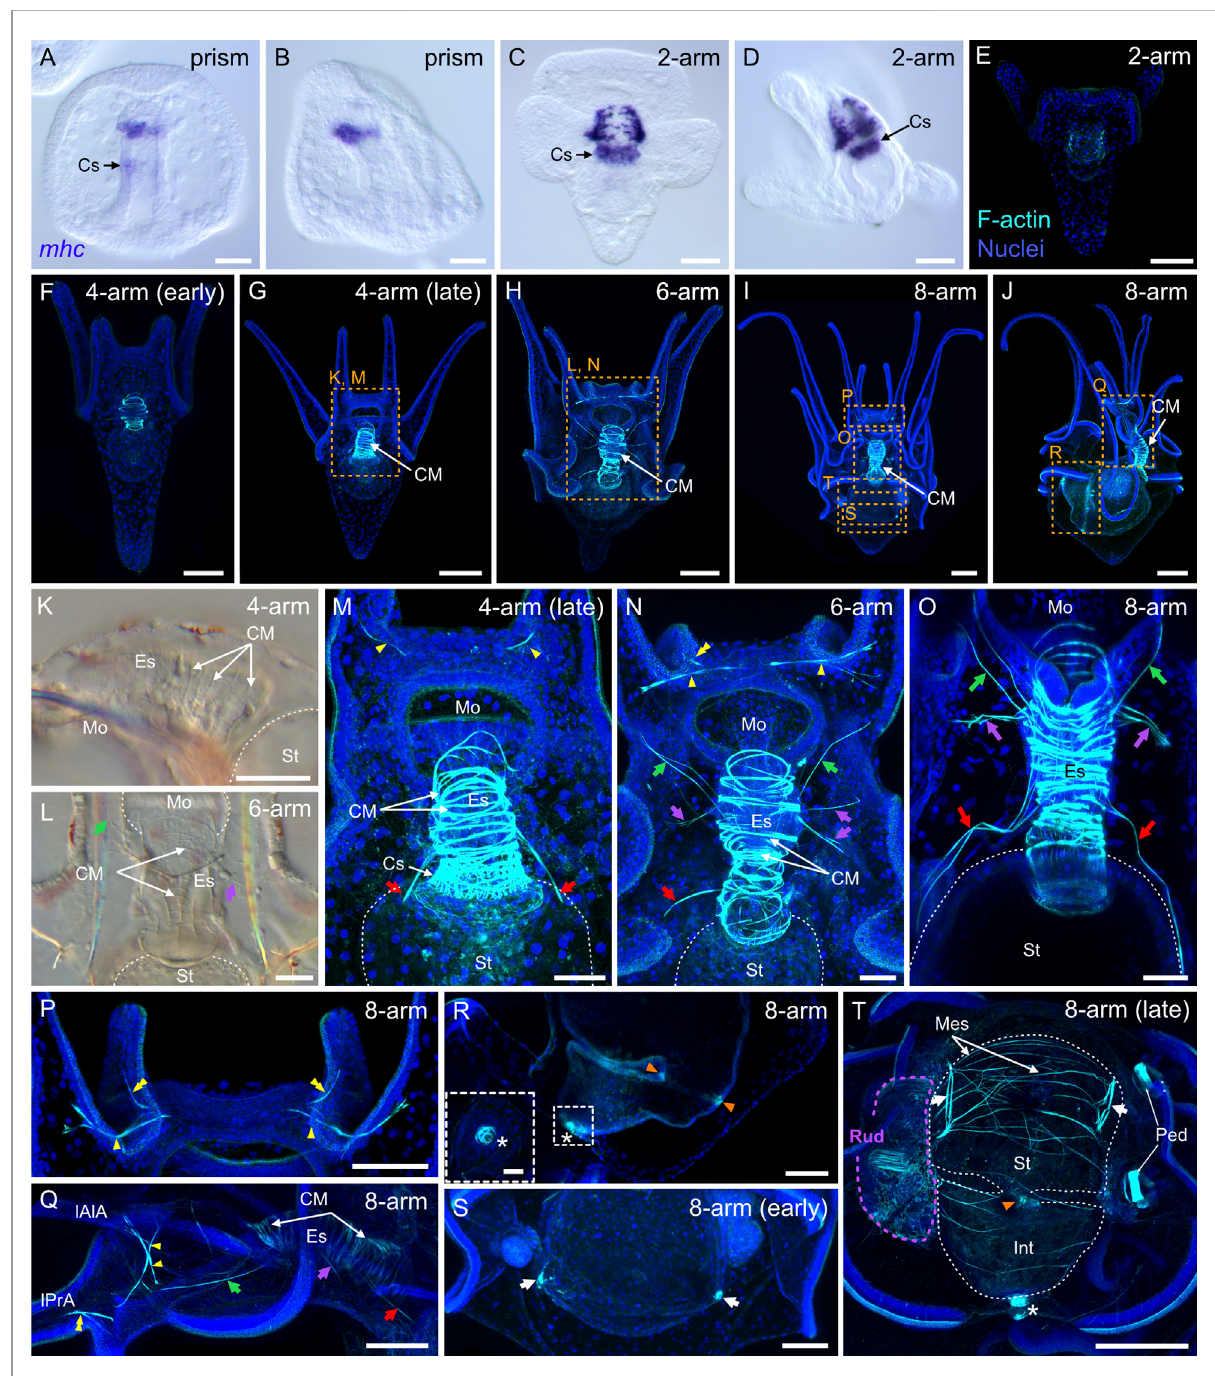
FIGURE 10 Myogenesis in Paracentrotus lividus during the embryonic and larval periods. Developmental stages are as follows: (A,B) prism stage (prism); (C – E) 2-arm pluteus stage (2-arm); (F,G,K,M) 4-arm pluteus stage (4-arm); (H,L,N) 6-arm pluteus stage (6-arm); (I,J,O – T) 8-arm pluteus stage (8- arm).Theuseof(early)or(late)associatedwiththestagenamessimplyhighlightsheremorespeci fi cperiodsduringthe4-or8-armpluteusstages.In (A – D) , images were acquired using bright- fi eld, differential interference contrast light, and they correspond to embryos and larvae labeled for themuscleterminaldifferentiationgene myosinheavychain ( mhc ).In (E – J,M – T) ,imagesaremaximumintensityprojectionsofconfocalz-stacksof larvaeco-labeledforF-actin(muscles;cyan)andDNA(nuclei;blue),andtheycorrespondtoprojectionsoftheentirespecimen.In (K,L) ,imageswere acquired using bright- fi eld light microscopy. In (A) , theembryo isin ventral view, with the animal pole up. In (B,D,J,K,Q,R) , embryos and larvae are in left view, with either the animal pole up and the ventral side left in (B) or with the anterior pole up and the ventral side left in (D,K,Q,R) or with the anteriorpolerightandtheventralsideupin (J) .In (C,E – I,L – P,S,T) ,larvaeareinanteriorview,withtheventralsideup. (K – T) Close-upsoftheregions outlined byorangeboxes in (G – J) . (K – O,Q) Close-upsoftheesophagealregion. (P) Close-up oftheoralhood. (R) Close-up